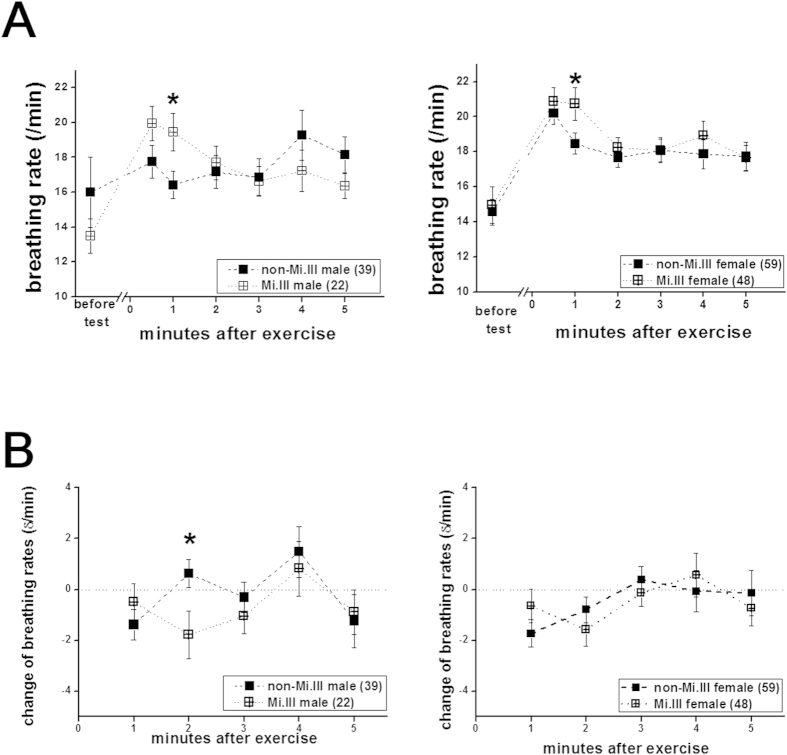
Breathing rates were also significantly higher in Mi.III+subjects immediately following the step test.Left: data from the male participants; right: from the female participants. (A) Breathing rates for Mi.III (cross symbols) and non-Mi.III (solid symbols) immediately before and after the exercise test. Faster respiration was observed within the first minute after exercise in Mi.III than in non-Mi.III subjects, regardless of their gender. The differences in breathing rates subdued at later measured time points. (B) Minute-to-minute changes of breathing rates. Shown mean ± SEM. *p < 0.05.